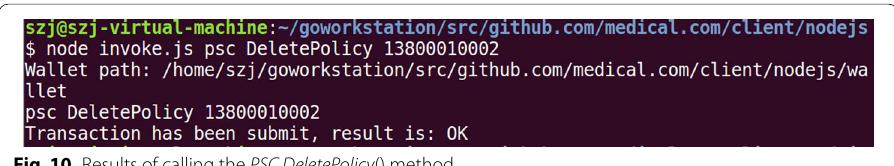
Fig. 10 Results of calling the PSC . DeletePolicy ()